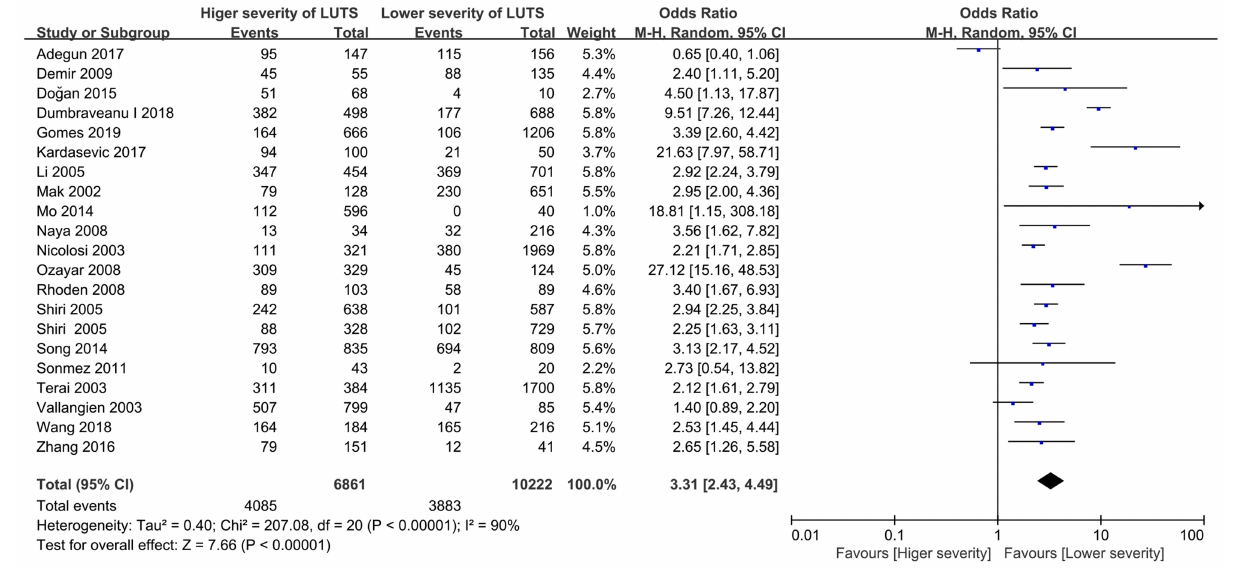
FIGURE 2 | Forest plot showing meta-analysis results of the association between LUTS severity and sexual dysfunction prevalence using dichotomous data. LUTS, lower urinary tract symptoms; CI, confidence interval.